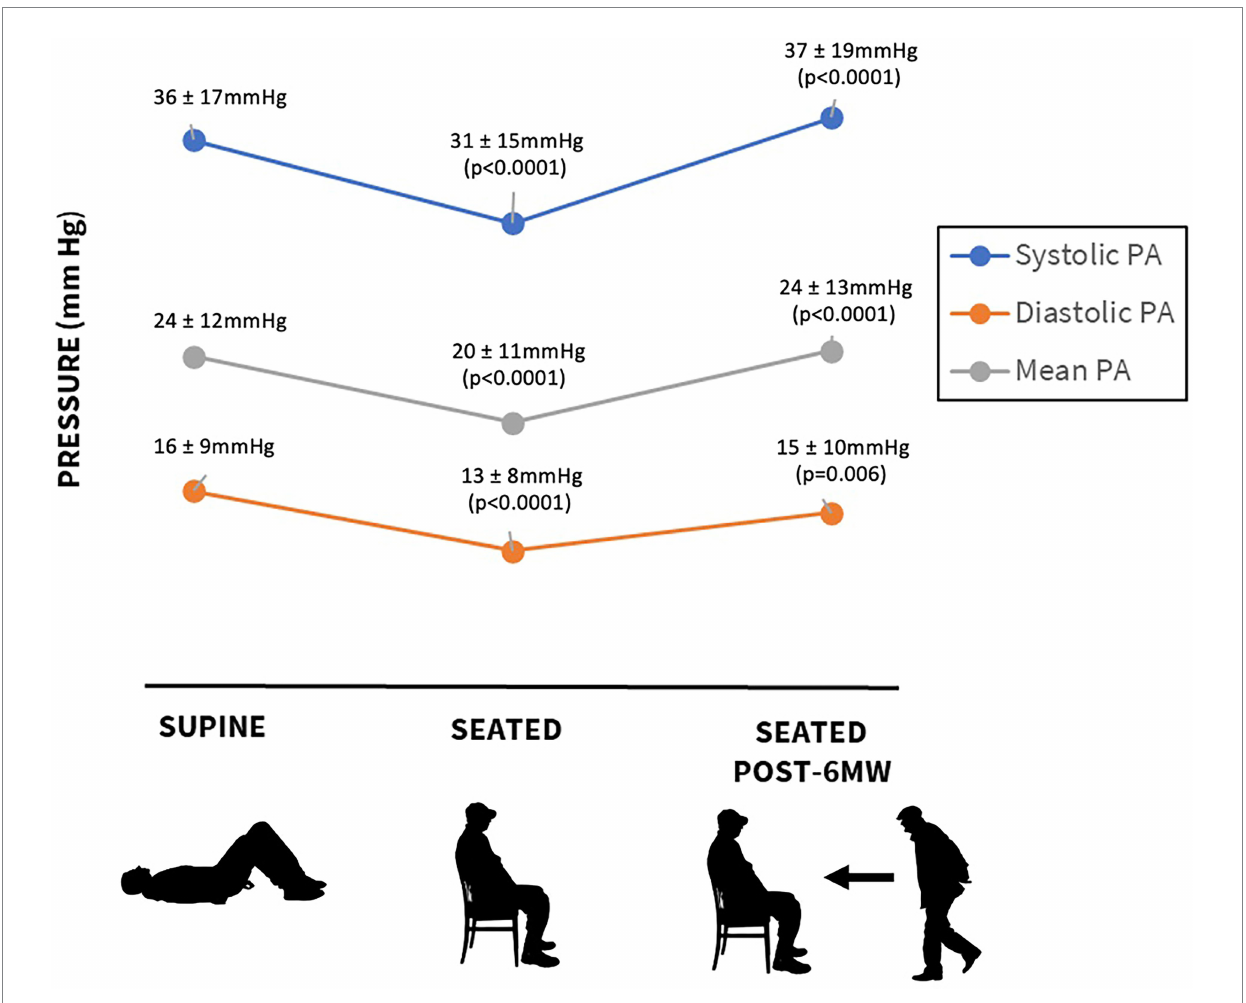
FIGURE 1 Changes in pulmonary pressures based on position and post 6-min walk